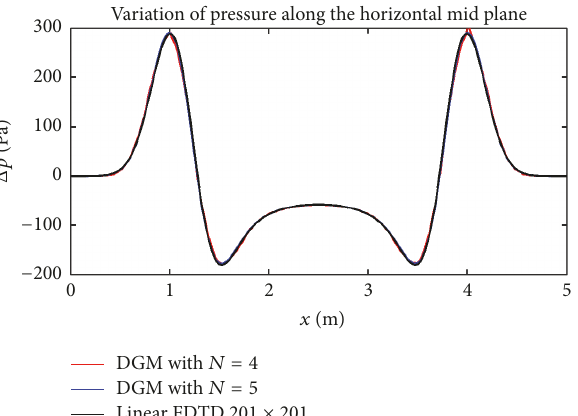
Figure 4: Pressure distribution at 𝑡 = 5 ms and 𝑦 = 0 comparison for the Finite Difference Time Domain (FDTD) method and DG method at orders 4 and 5.